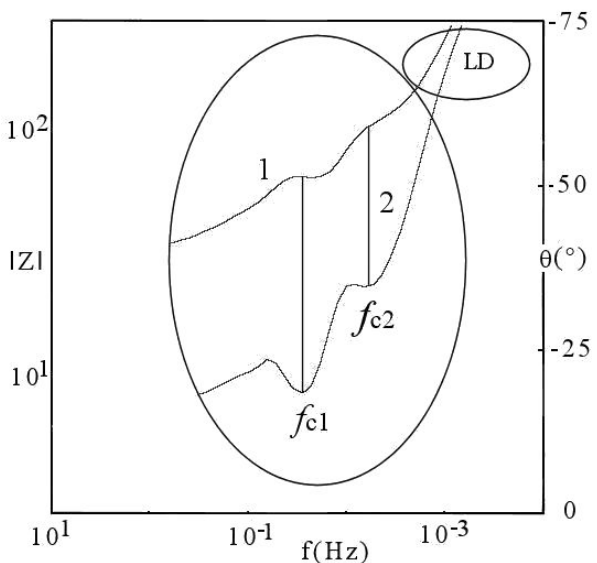
Figure 9. Reversed Bode spectrum corresponding to two characteristic Warburg behavior ( f c ( 1,2 ) ), (1): on impedance; (2): on θ phase-angle at low frequency (ellipse) in an active region with hydrogen blocking